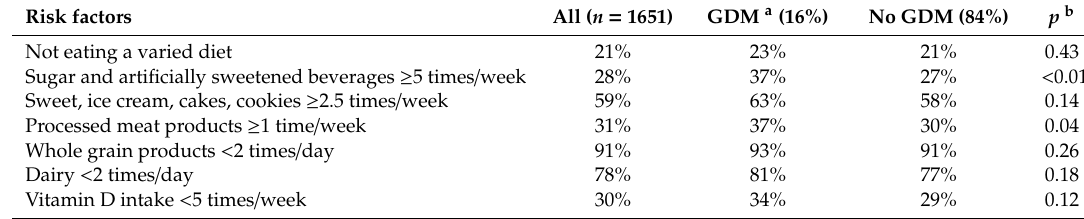
Table 2. Percent of women fulfilling the predefined risk